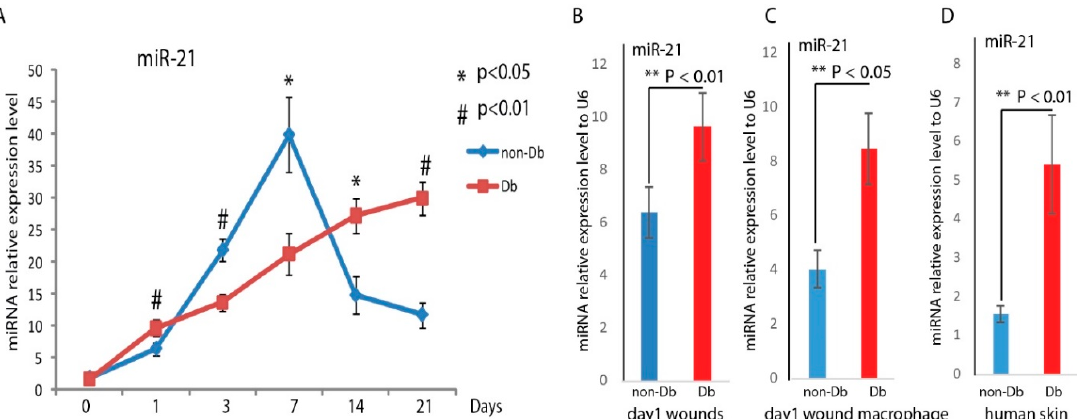
Figure 1. Dynamic RNA abundance changes of miR-21 during the wound healing process. ( A ) Real-time qPCR analysis of miR-21 levels in diabetic (Db) /+ ( n = 5) and Db / Db ( n = 5) wounds at days 0, 1, 3, 7, 14, and 21 after dermal injury. MiR-21 RNA abundance was calculated after normalizing with U6. * pp < 0.01 comparing Db / Db wounds to Db /+ wounds; ( B ) RNA analyses by real-time qPCR showed significantly increased miR-21 RNA abundance in mouse diabetic and non-diabetic dermal wounds at day 1 (mean + SD, n = 5 per group) after injury, also in diabetic day 1 wound macrophage ( C ), and ( D ) in human non-diabetic and diabetic skin.